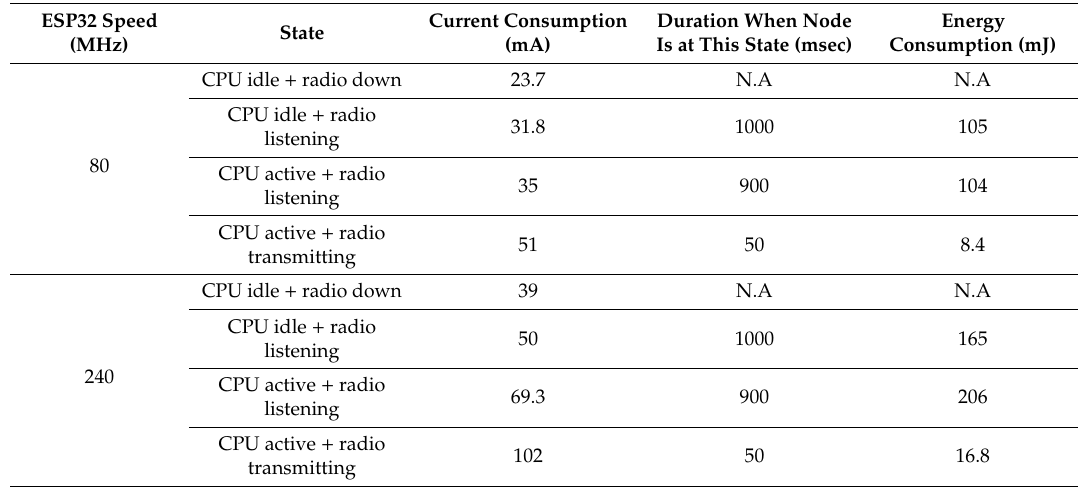
Table 4. Measured current consumption of the sensor node at di ff erent